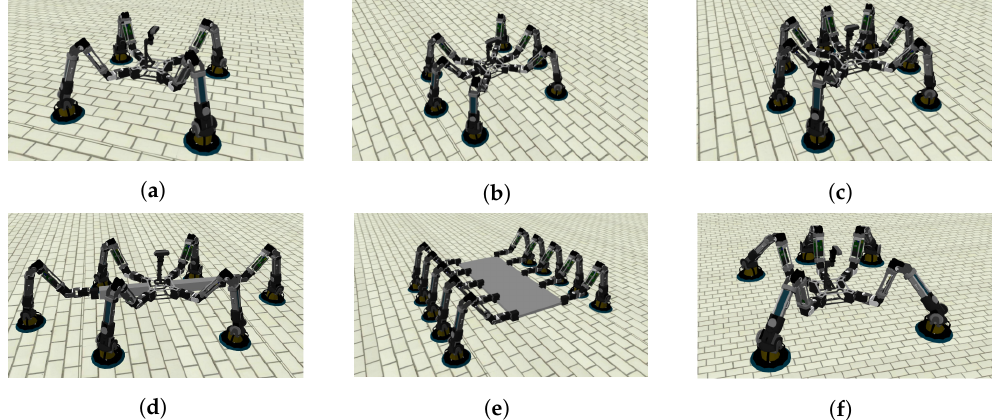
Figure 10. Examples of tested organism arrangements. ( a ) 4 legs, ( b ) 6 legs, 1st configuration, ( c ) 10 legs, ( d ) 6 legs, 2nd configuration, ( e ) 7 legs, and ( f ) 5